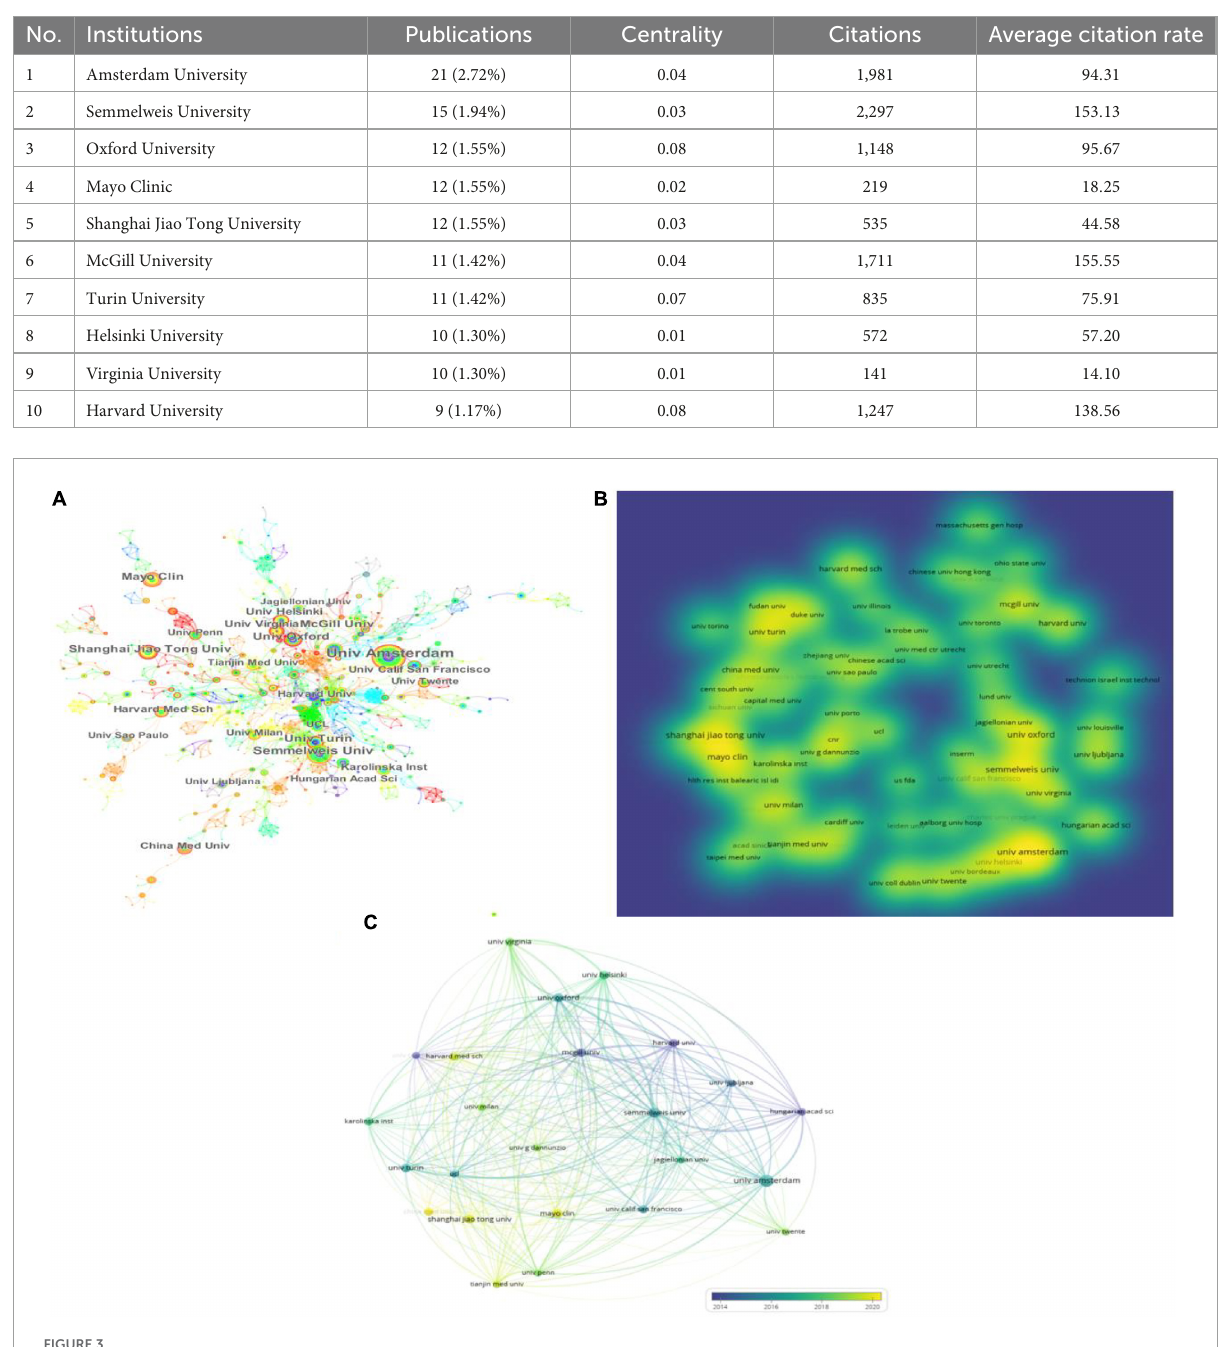
The number of citations for a publication